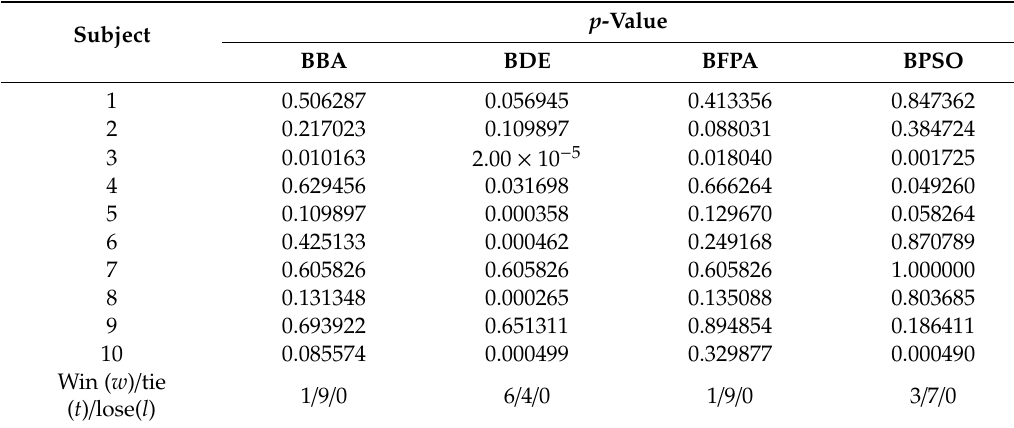
Table 3. p -Value of the t -test on 10